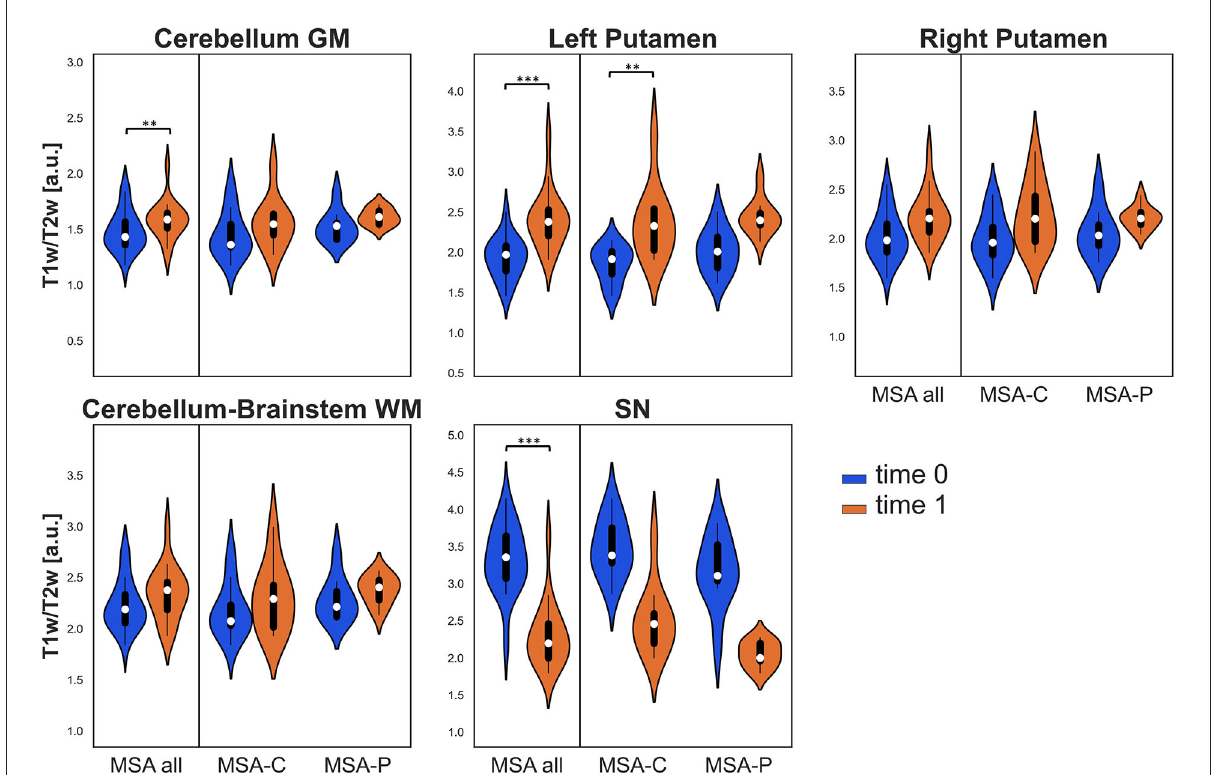
FIGURE2 Violin plots describing the distribution of regional T1w/T2w values in all the considered ROIs. Values at baseline ( t 0) are in blue, while values at follow-up ( t 1) are in orange for the entire MSA group and for both MSA subgroups. Significant differences are indicated with asterisks. ** p < 0.01, *** p <